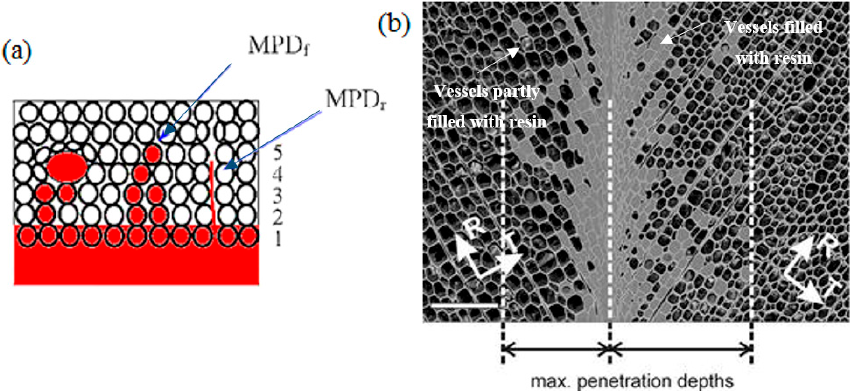
Figure 9. ( a ) Illustration of numbers of filled fibers (FFN), numbers of filled vessels (FVN), maximum penetration depth in fibers (MPD f ), and maximum penetration depth in rays (MPD r ) [157], Reproduced with permission from Springer; ( b ) states of adhesives filled in vessels [149], Reproduced with permission from Springer.